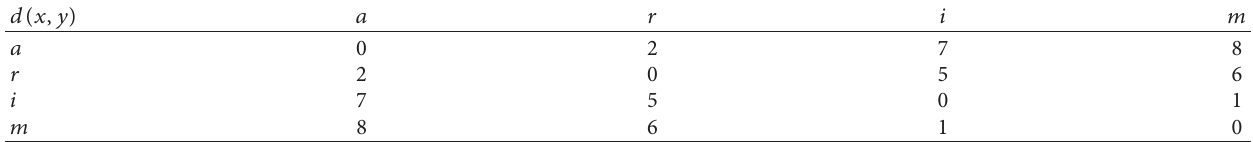
Table 3: Table of metric d for Example